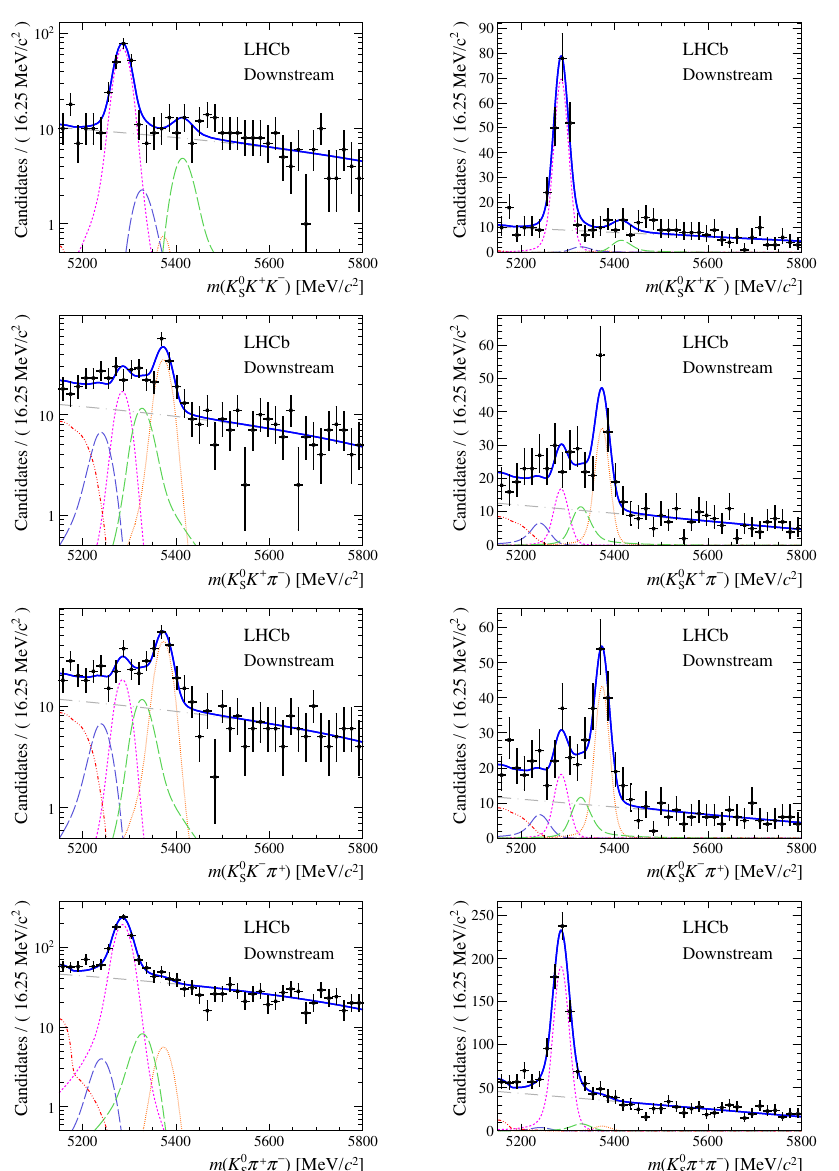
Figure 4 . Results of the simultaneous (cid:12)t to data (downstream, 2012a) with the BDT optimisation corresponding to the favoured decay modes. The modes K 0 K 0 (cid:25) + (cid:25) (cid:0) are shown from top to bottom. The left-hand side plots show the results with a logarithmic S scale and the right-hand side with a linear scale. Legend is similar to that of plots shown in (cid:12)gure 1.